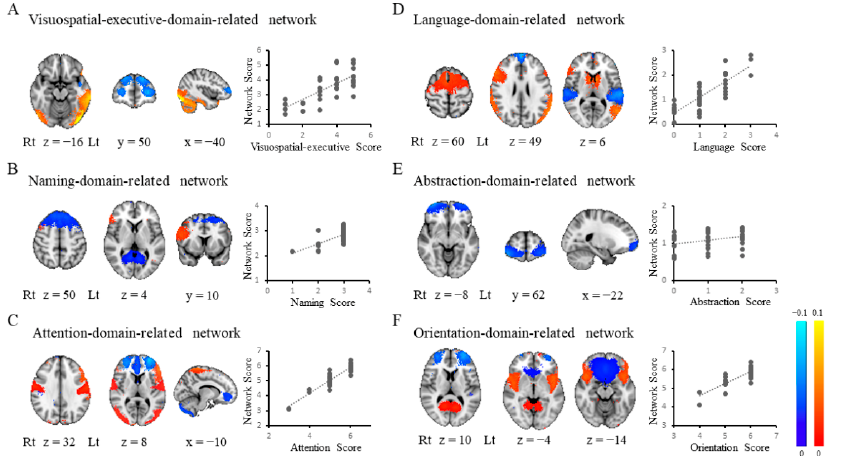
Figure 2. Each domain-related network. Each domain-related network was determined with a multiple regression model to explain the relationship between brain networks and each domain score: ( A ) the visuospatial executive domain, ( B ) the naming domain, ( C ) the attention domain, ( D ) the language domain, ( E ) the abstraction domain, or ( F ) the orientation domain. The cerebellum is featured in the visuospatial-executive-domain-related and attention- domain-related networks ( A , B ). Lt, left; Rt, right.